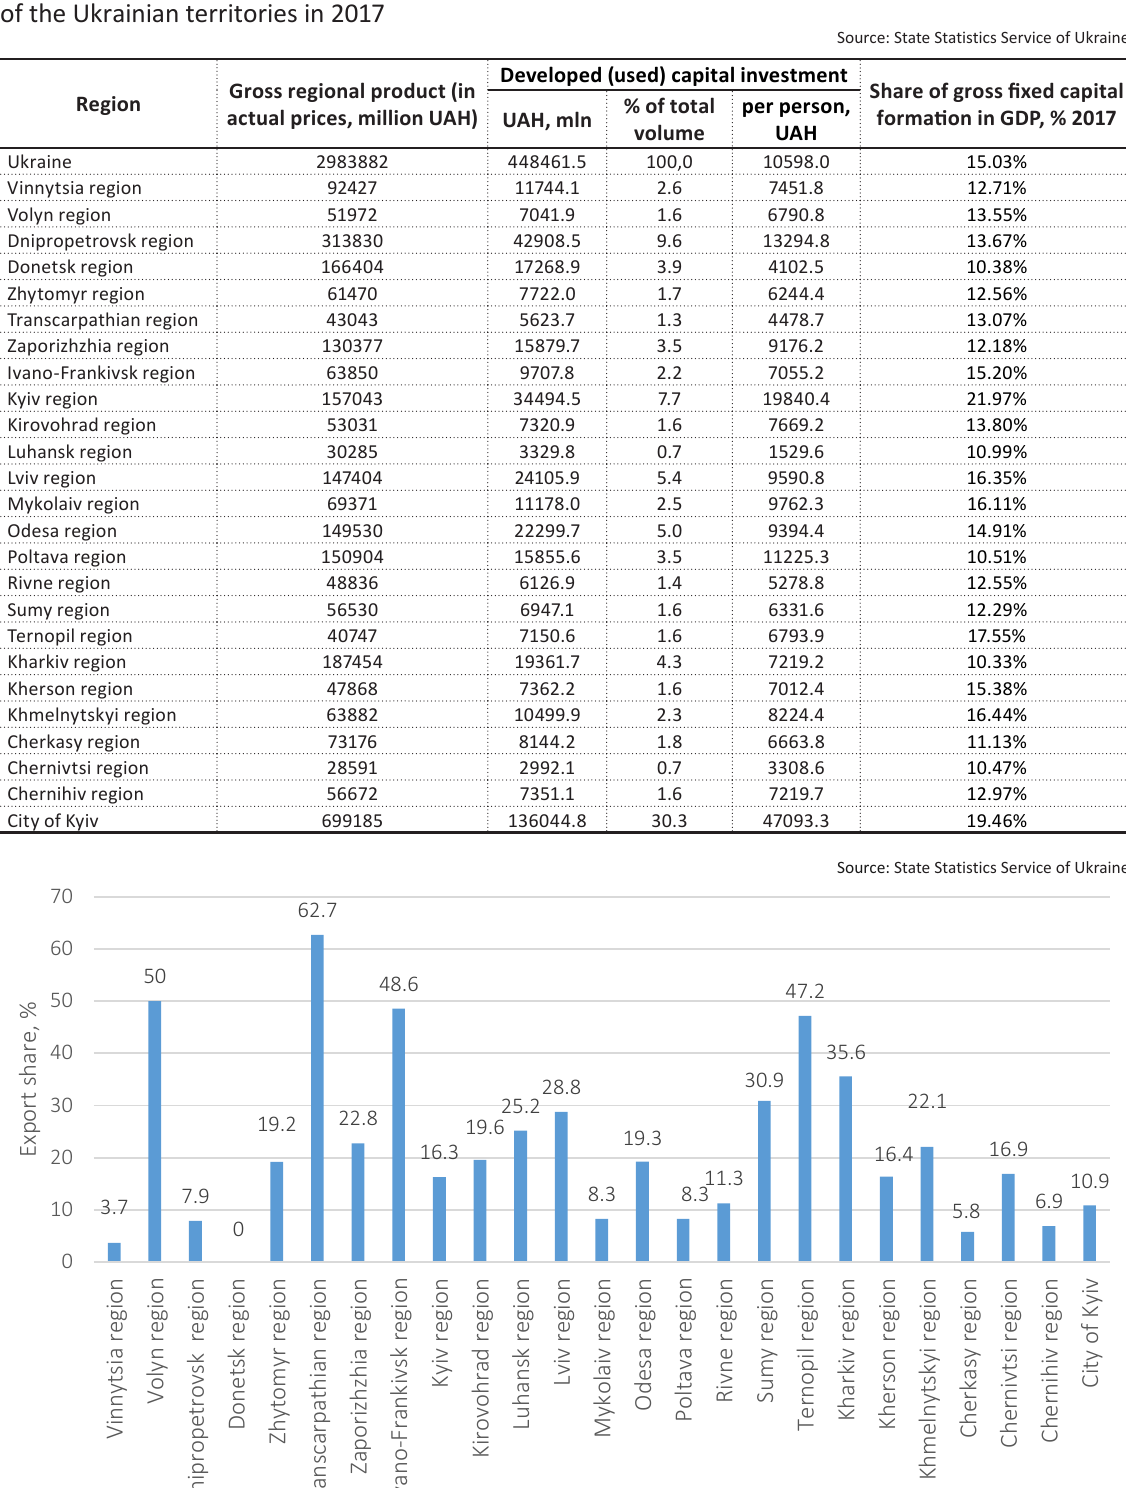
Table 4. Indicators of evaluation of investment and innovation component of the economic potential of the Ukrainian territories in 2017